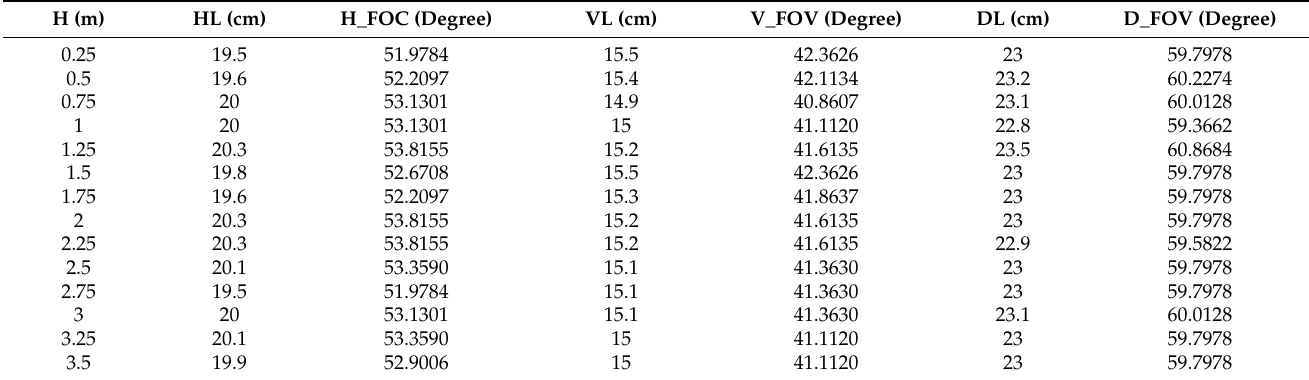
Table 1. Indoor FOV measurement with fixed distance (20 cm) and varying heights, Height (H), Horizontal Length (HL), Horizontal Fov (H_FOC), Vertical Length (VL), Vertical Fov (V_FOV), Diagonal Length (DL), Diagonal Fov (D_FOV).